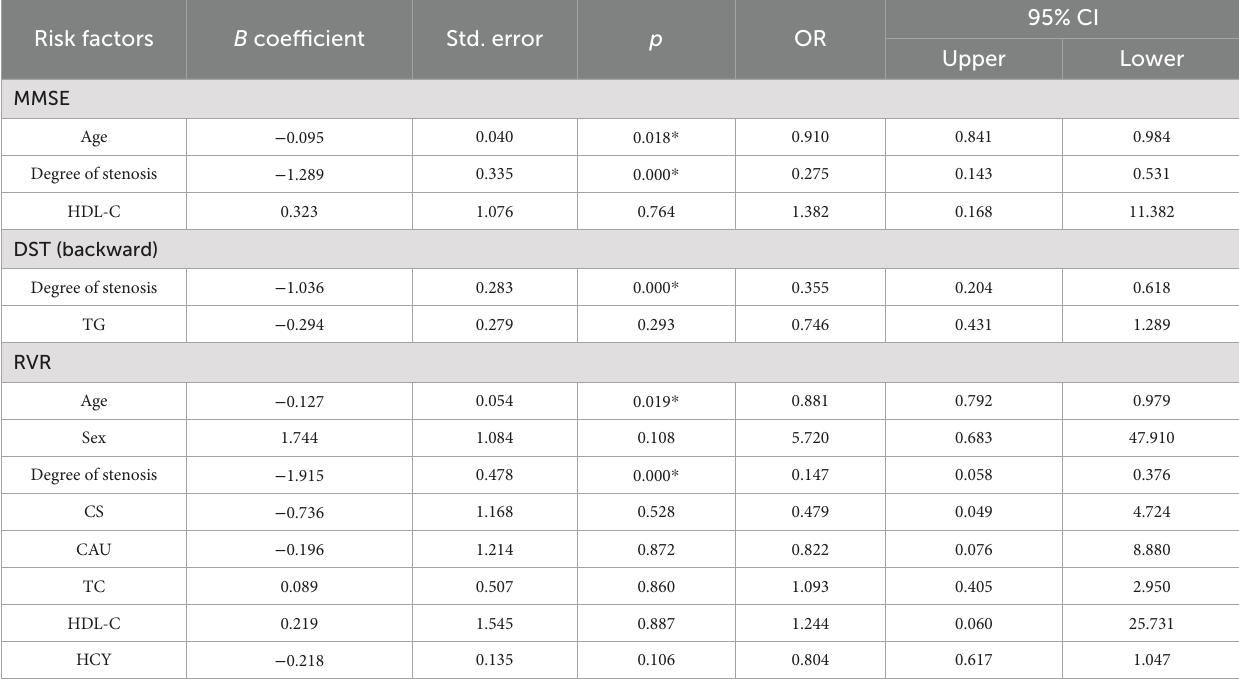
TABLE 5 Multiple logistic regression analysis for risk factors of cognitive impairment in patients with left carotid artery stenosis.